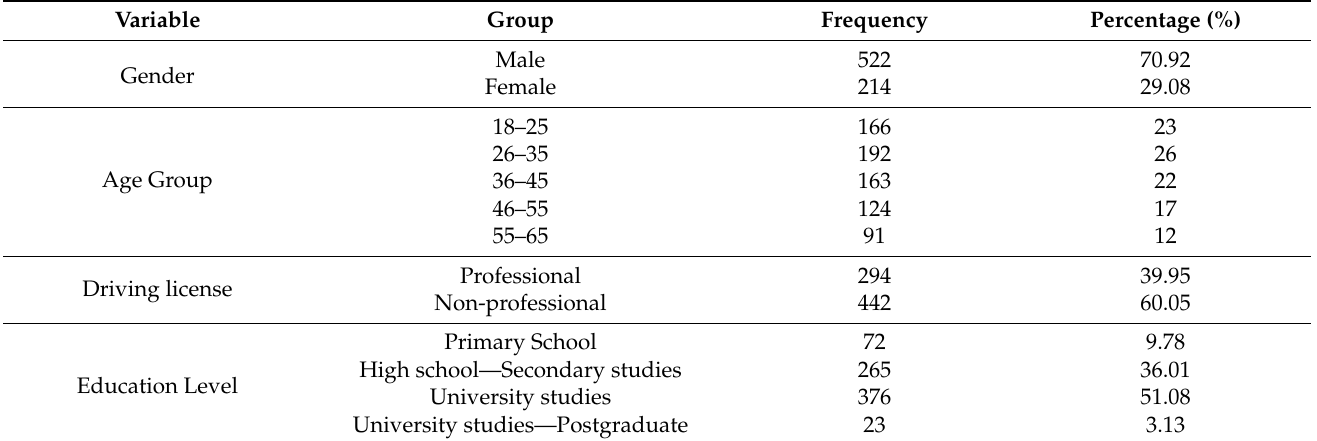
Table 2. Socio-demographic characteristics of the 736 drivers with valid